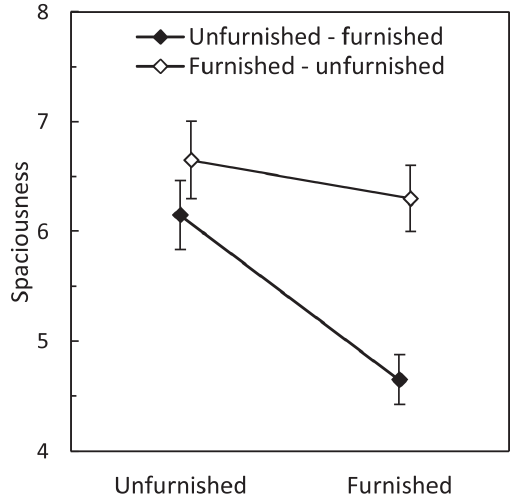
Figure 5. Experiment 1: Mean spaciousness judgments as a function of furnishing and presentation order. Error bars show 6 1 SEM of the 40 subjects in each factor level combination. (see Figure 2). For example, the center of the cupboard divided the room width from the left to the right at a constant ratio of 5:3. Walls and ceiling were overlaid with a white fine-grained texture. The floor was overlaid with a medium grey fine-grained texture. Shadows at the room edges were provided for a more realistic lighting impression. Cuboids were colored in light grey. Thin dark grey lines accentuated the cuboids’ edges. Luminance intensity was kept constant in all conditions. Figure 6 shows screenshots of the smallest and the largest virtual room. The virtual rooms were displayed using Vizard [51] on a Pentium IV computer with a NVIDIA QuadroFX3500 graphics board and presented on a 2.60 m wide and 1.95 m high screen (aspect ratio 4:3). The stereoscopic projection was generated by a 3D rear-projector (projectiondesign F10 AS3D) with a resolution of 1,400 6 1,050 pixels and a color depth of 32 bits. Subjects wore LCD shutter glasses (XPAND X102) whose shifting time was synchronized with the projector’s refresh rate via an infrared connection. The projector’s refresh rate was 120 Hz, providing each eye with 60 pictures per second. The individual inter- pupillary distance of each subject was measured before the experiment and taken into account in computing the stereoscopic disparity of the two images. During the experiment, subjects sat on a height-adjustable chair. A chin rest provided for a constant eye position which was horizontally and vertically centered to the projection screen. The distance between the observer’s eyes and the projection screen was 2 m. The enclosed visual angle was 66 u horizontally and 52 u vertically. The observer’s virtual position was 20 cm in front of the virtual room’s (invisible) front wall, horizontally centered inside the virtual room. Virtual eye height was set at 1.60 m. Subjects were told that their virtual position was like leaning with their back against the horizontal center of the virtual room’s front wall. The default setting of the virtual viewing direction was horizontally and vertically perpendicular to the virtual room’s rear wall. Using a mouse wheel, subjects could turn the virtual horizontal direction of the 66 u -wide viewing angle 48 u to the left and 48 u to the right. Thus, the total visible horizontal viewing angle was 162 u (see Figure 7).